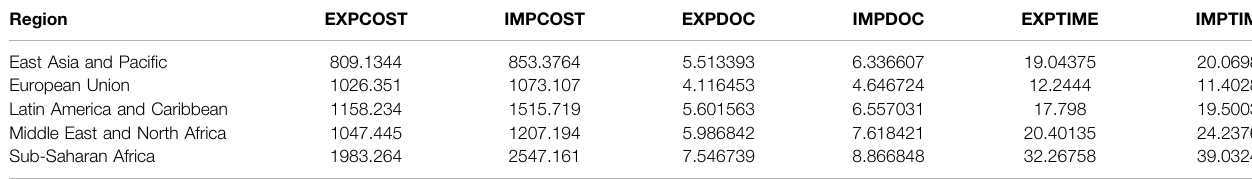
TABLE 1 | Regional comparison of trade facilitation measures on doing business Region